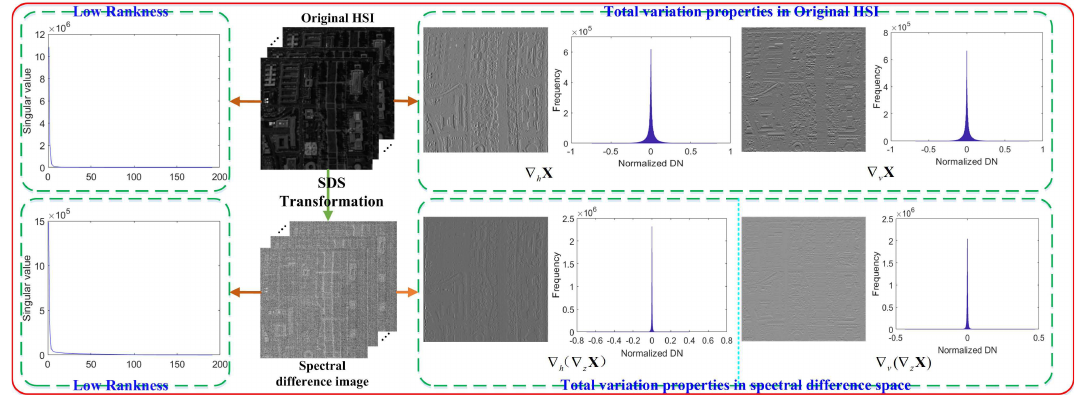
Figure 3. Comparison of low rankness and total variation properties in the original HSI and